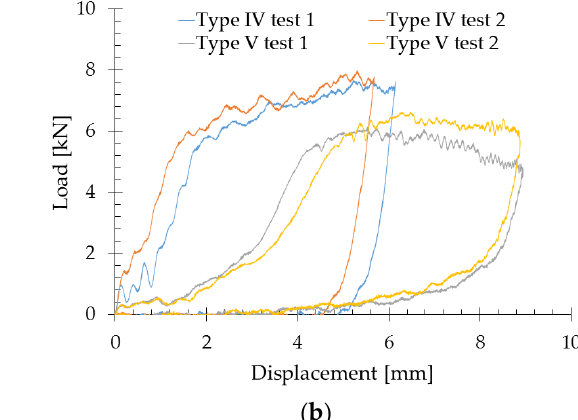
Figure 6. Maximum SAE versus total thickness.